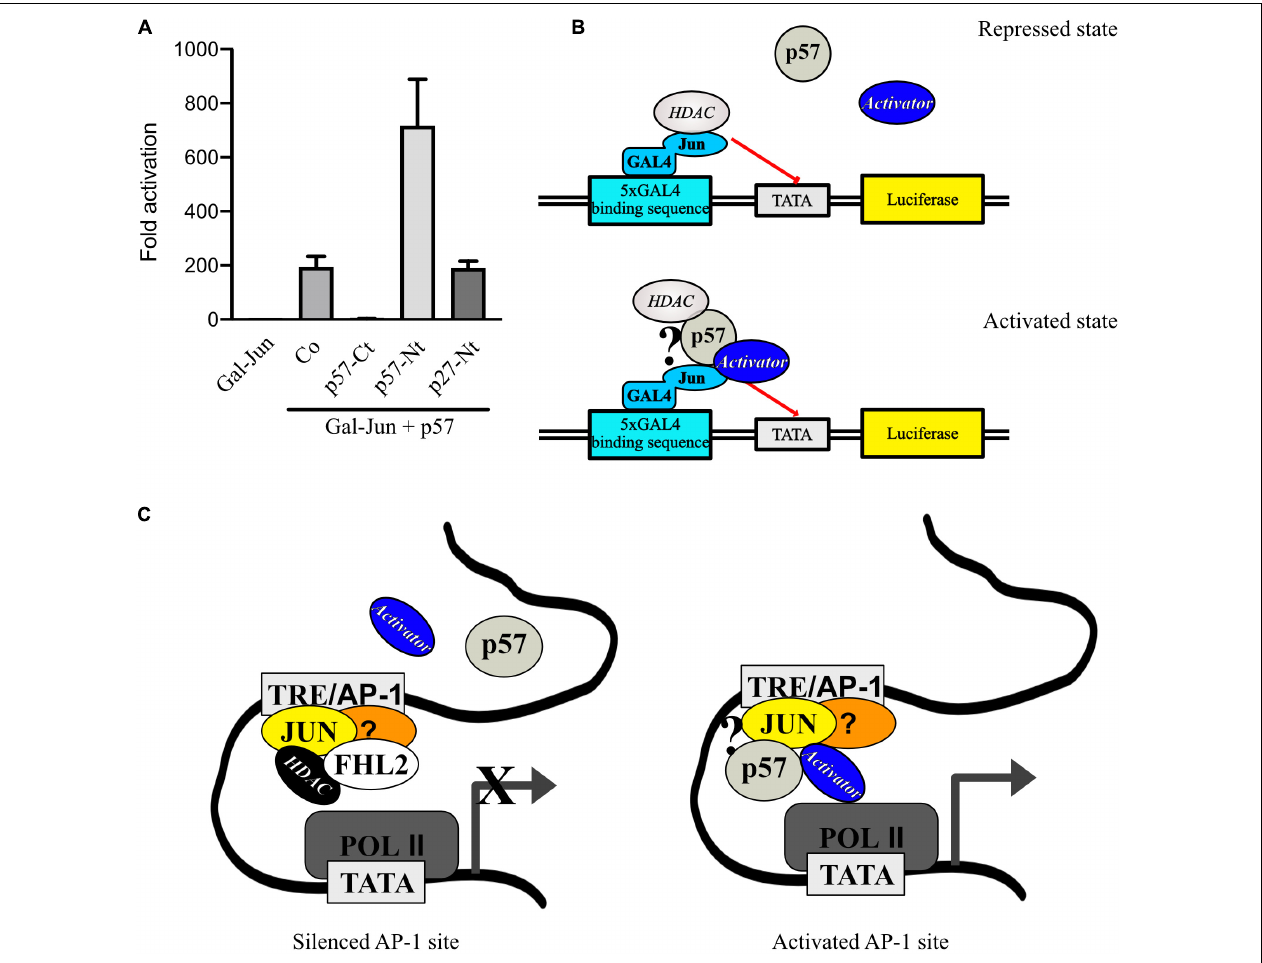
FIGURE 6 | p57 might recruit transcription repressors and activators to c-Jun. (A) Gal4-dependent luciferase reporter gene experiments analyzing the effect of p57-domain coexpression on p57-induced c-Jun-activation. Coexpression of p57-Ct may titrate out activators and coexpression of p57-Nt may titrate out repressors of c-Jun activation by p57. 293FR cells were cotransfected with expression plasmids for Gal-Jun, pUbi-Rluc, and p57 wildtype together with vectors expressing p57-Ct or p57-Nt or the related aminoterminal CDK-inhibitory domain of p27 (p27-Nt). A total of 30 h after transfection cells were harvested and subjected to Dual luciferase assays. Renilla-normalized values are expressed as fold activation relative to control transfected (Co.) which is set to 1. Shown is the mean ± SD from three independent experiments. (B) Mechanistic models for p57 in stimulating Gal-Jun transactivation function and a schematic of a putative transcription complex. (C) Model how p57 and FHL2 might act at endogenous promoters at AP-1 sites (TRE). Question mark in (B) and (C) indicates that there is no experimental proof for a direct interaction of p57 with the depicted proteins. For details see